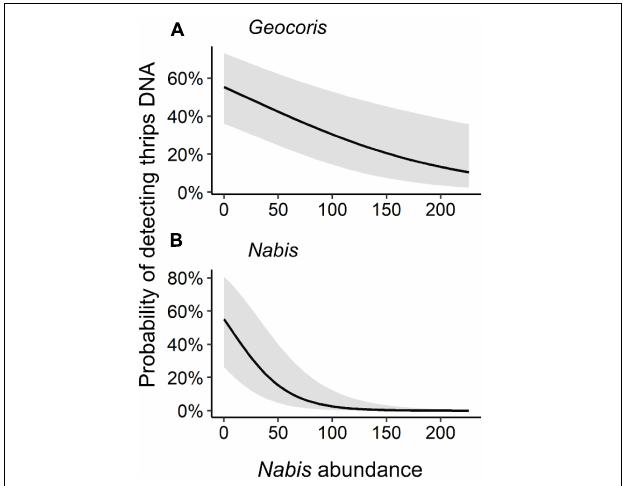
FIGURE 3 | Probability of detection of western flower thrips DNA in (A) Geocoris and (B) Nabis by Nabis abundance. Gray bands are 95% confidence interval. Figure shows the predicted values from the best-supported models using the “plot_model” function in the sjPlot package in R. X -variables were standardized in the candidate model set but are plotted on the original scale for visualization.